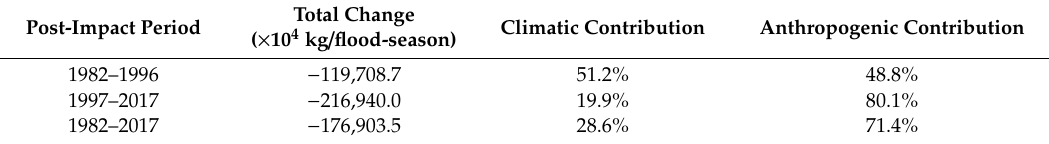
Figure 7. Comparisons of flood season’s runo ff and sediment and their changes due to climate variability and human activities in the post-impact period in the Yunyan River Basin. Panels ( a ) and ( b ) are for runo ff volume and sediment load at Xinshihe station, respectively. ∆ Q total , ∆ Q climate , and ∆ Q human represent the total runoff change and the separated changes due to climate variability and human activities, respectively, while ∆ S total , ∆ S climate , and ∆ S human are the corresponding notations for sediment load. Table 2. Attribution analysis of flood season’s sediment reduction for different post-impact periods.